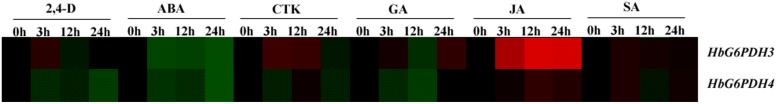
Responses of HbG6PDH3 and HbG6PDH4 to six plant hormones, viz. 2, 4-dichlorophenoxyacetic acid (2, 4-D), abscisic acid (ABA), cytokinin (CTK), gibberellic (GA), jasmonic acid (JA), and salicylic acid (SA). The expression data are shown as fold change (log2) as calculated by the ratio between the control (0 h) and treatments (3, 12, and 24 h) for each gene. Different colors represent different changes in the HbG6PDH gene expression levels: black represents no change, green represents down-regulation and red represents up-regulation. The brightness indicates the degree of expression change.